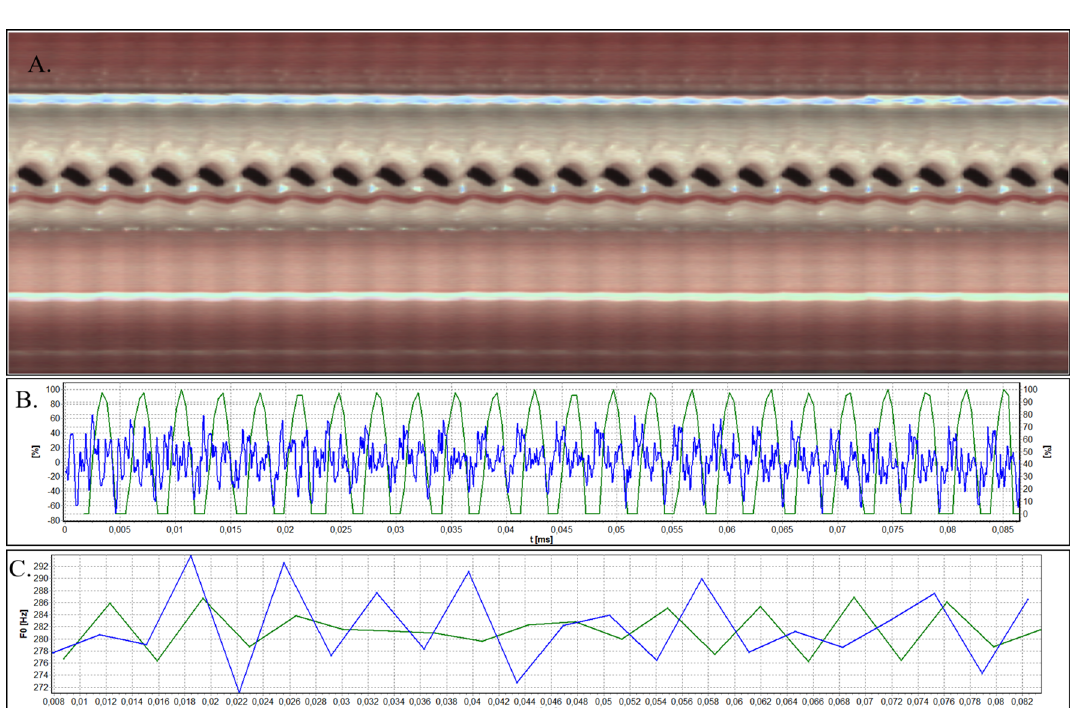
Figure 5. Analysis of HSV data acquired by means of rigid endoscope for Subject 2. ( A ). Videokymogram; ( B ) Comparison of the glottal width waveform obtained from a videokymogram (green line) and the audio signal oscillogram (blue line); ( C ) Comparison of F0 obtained from a videokymogram (green line) and acoustic voice analysis (blue